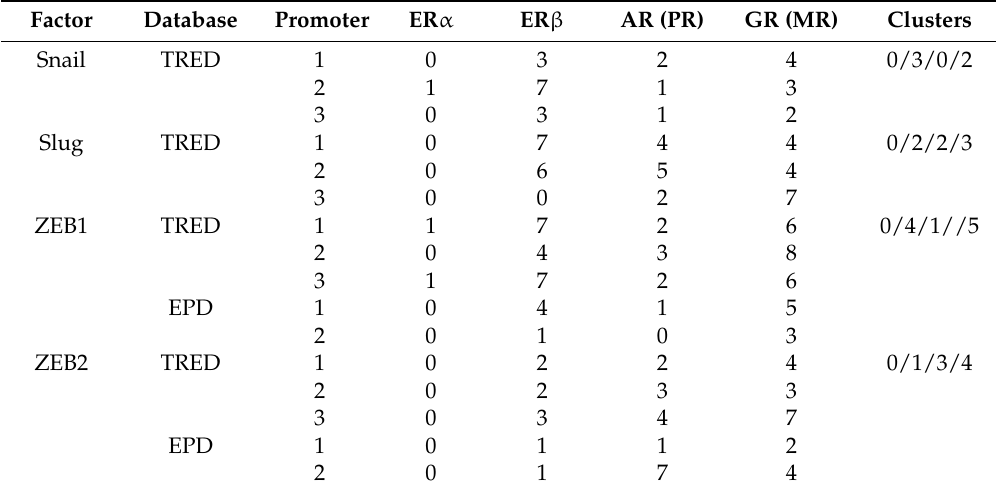
Table 1. Number of binding sites of Steroid Nuclear Receptors (SNRs) in the different promoters of EMT core transcription factors Snail, Slug and ZEB1 and ZEB2, listed in the TRED and EPD databases. Progesterone Receptor (PR) and Mineralocorticoid Receptor (MR) appear in parentheses in the Androgen Receptor (AR) and Glucocorticoid Receptor (GR) column headings, respectively, as they have the same binding sites. In the last column, the number of promoters with clusters (more than three) of binding sites for each SNR (ER α /ER β /AR/GR) is